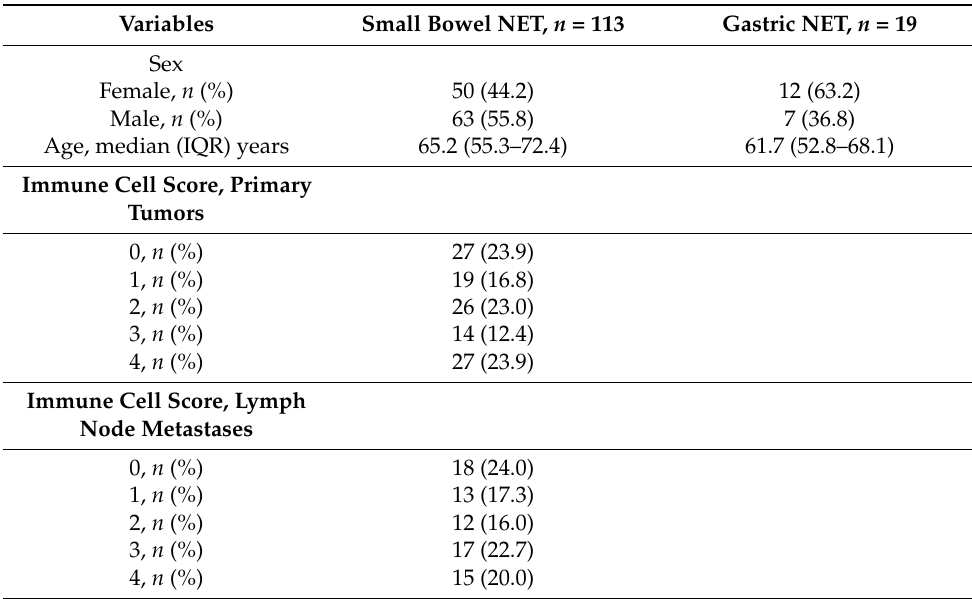
Table 1. Baseline characteristics of the study